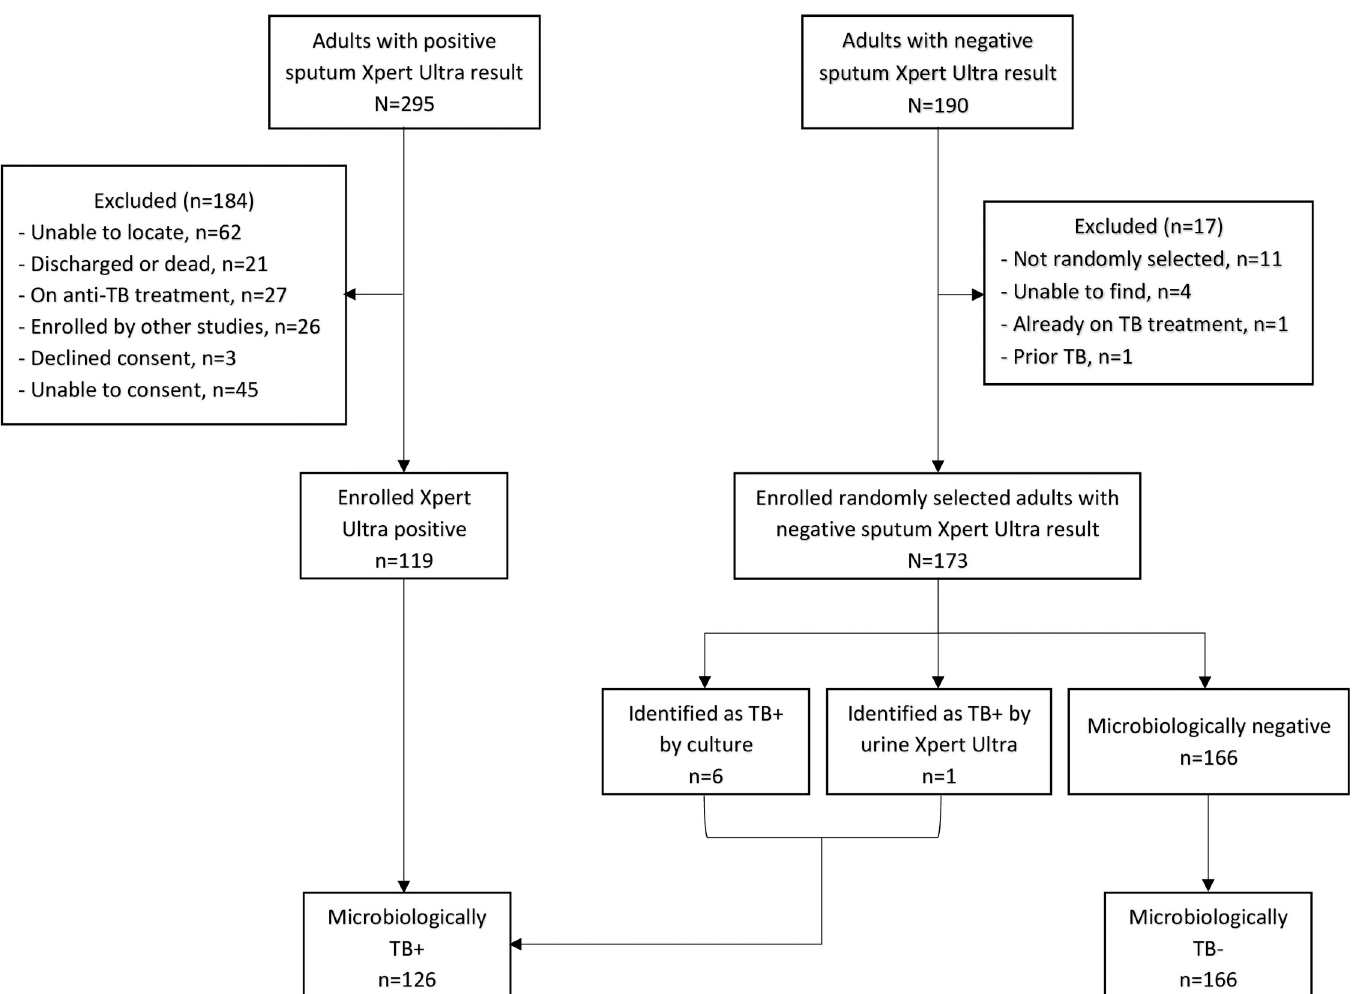
Fig 2. Flowchart of patient enrollment. We identified 295 adults with positive Xpert Ultra results to screen for enrollment. Of these individuals 119 were able to be enrolled in the study. A random selection of 173 adults with negative Xpert Ultra results were also enrolled. Of the 173 enrolled Xpert Ultra negative patients 7 were subsequently diagnosed as TB cases by other microbiological